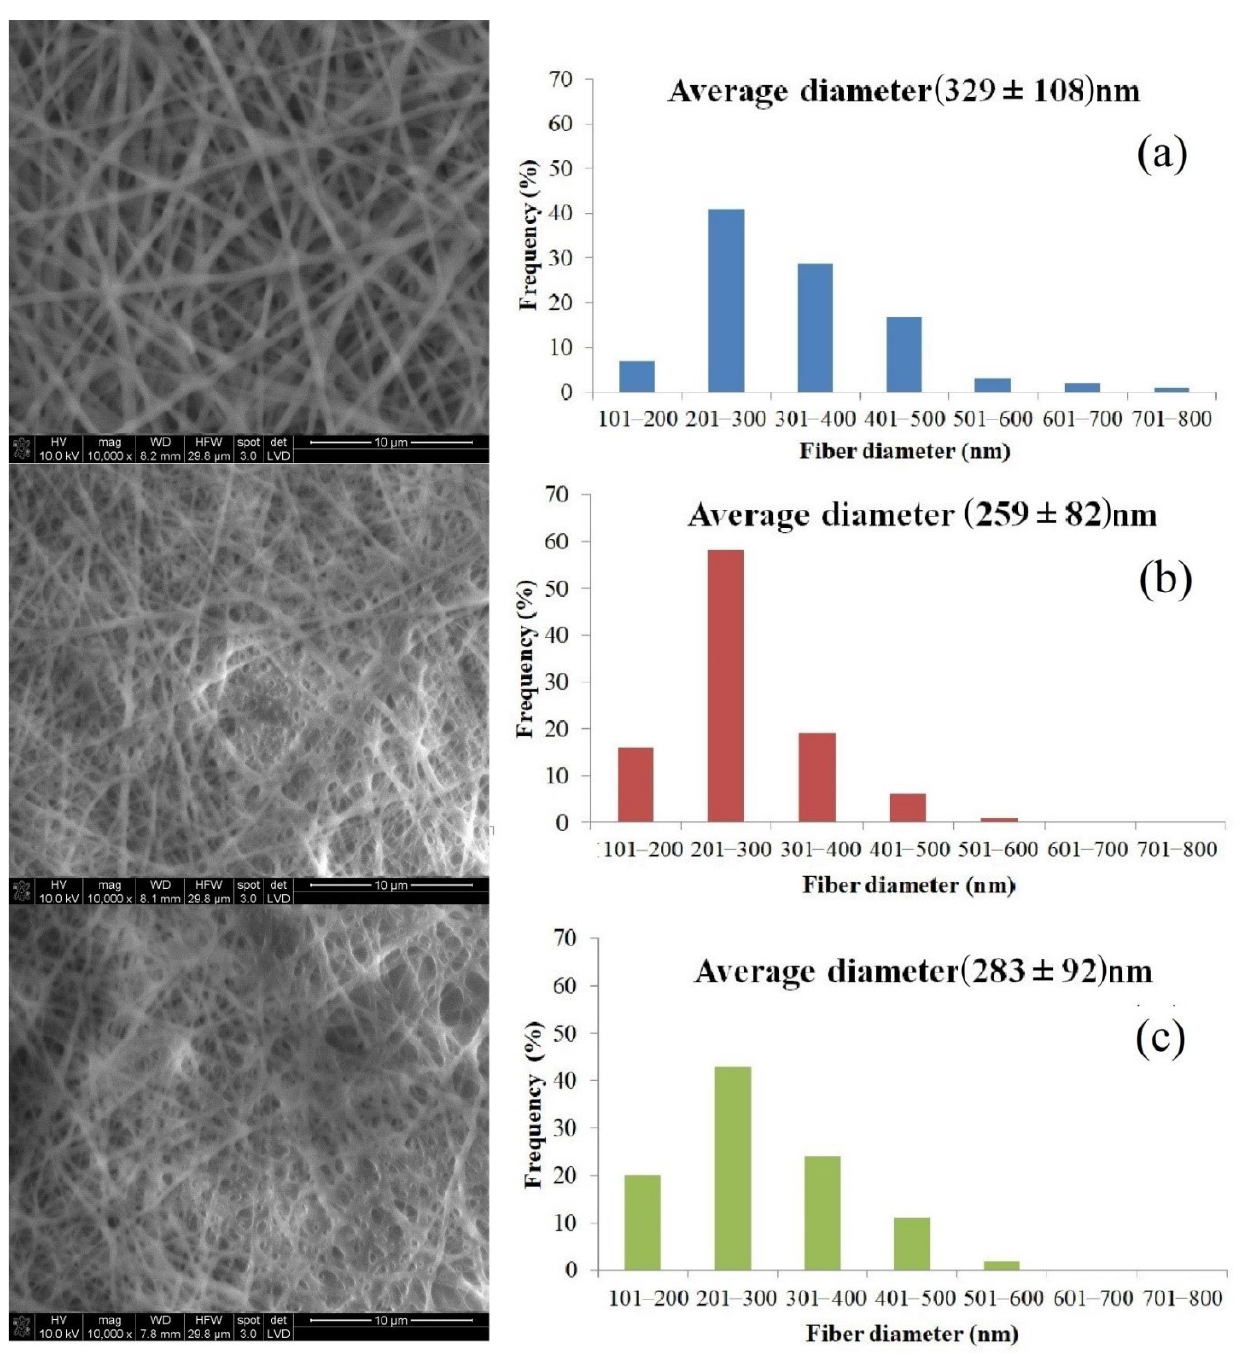
Figure 2. SEM morphology and diameter distribution of the PU and BCE/PU nanofibrous mats with BCE content ( a ) PU ( b ) 0.25-BCE/PU and ( c )